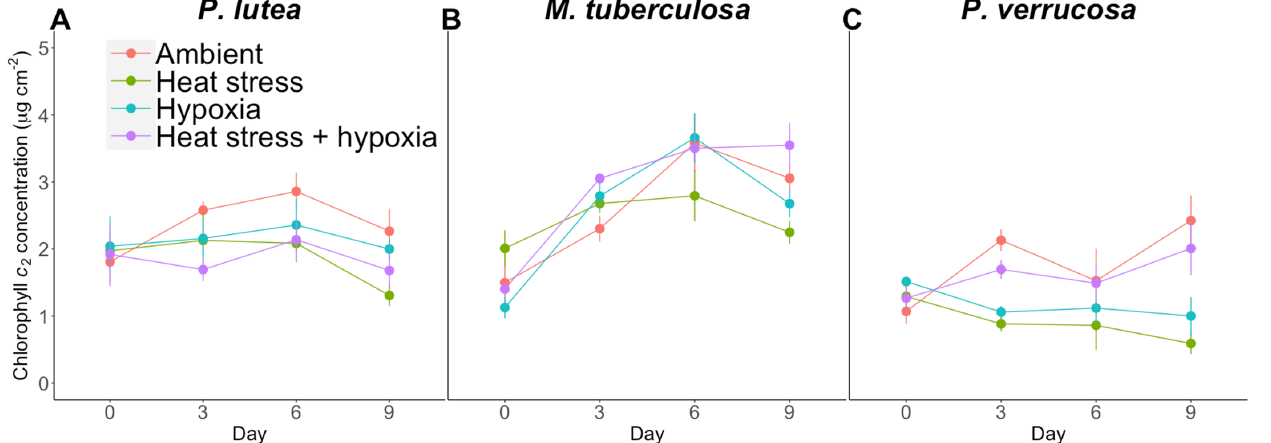
Figure 6. Chlorophyll c 2 concentration (µg cm − 2 ) of P. lutea ( A ), M. tuberculosa ( B ), and P. verrucosa ( C ) under ambient conditions, heat stress, hypoxia, and heat stress + hypoxia on days 0, 3, 6, and 9. Data are shown as mean ± SE ( n = 4).